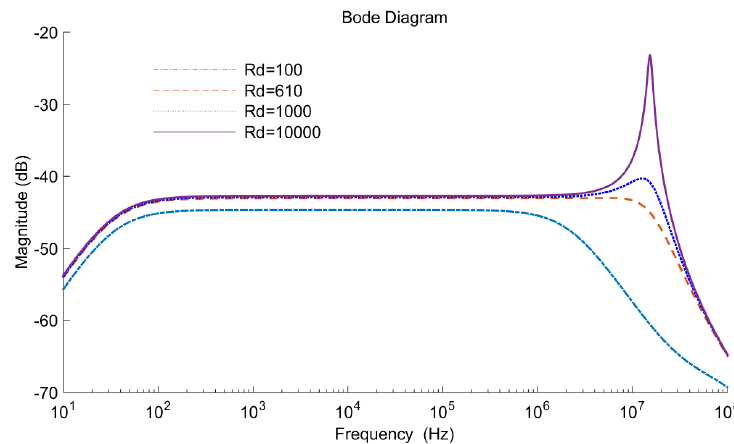
Figure 12. Amplitude-frequency response curve of the sensor under different load resistors.